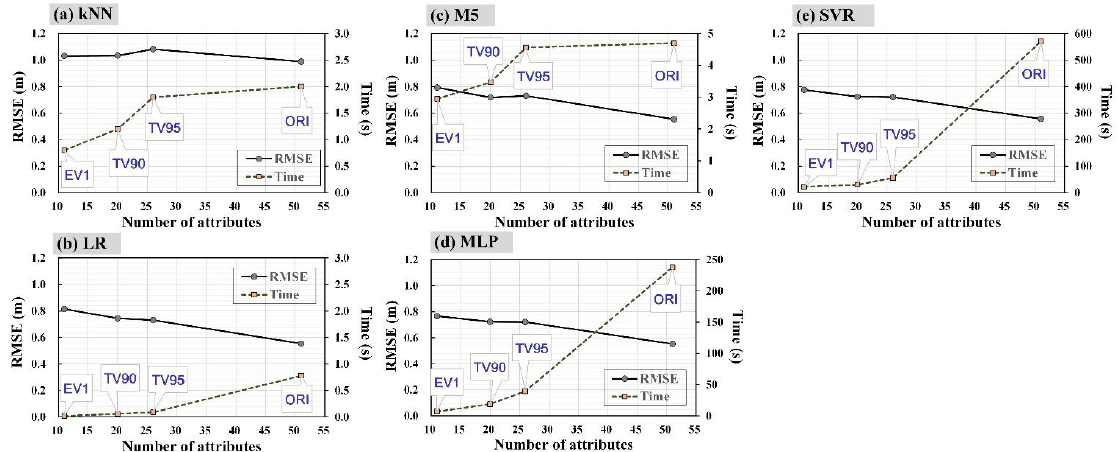
Figure 6. Effect of data reduction on computational time and prediction errors for ( a ) kNN, ( b ) LR, ( c ) M5, ( d ) MLP, and ( e ) SVR.